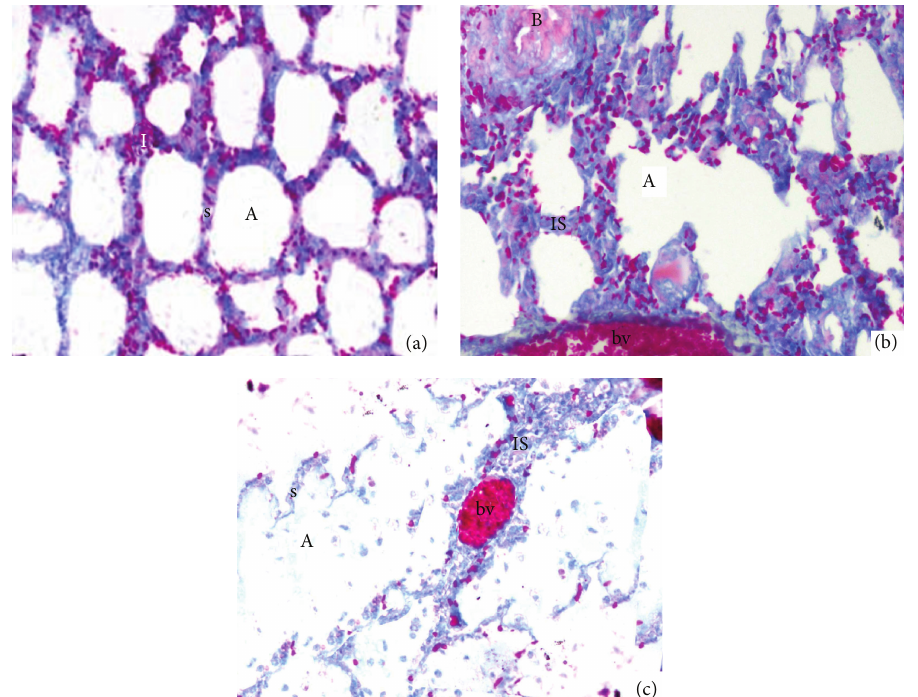
Figure 3: (a) A photomicrograph of transverse section in the control rat lung shows normal distribution of fibrous tissues and architecture of alveoli (A) with thin interalveolar septa (s) and normal interstitial tissues (I) (Mallory × 400). (b) A photomicrograph of transverse section in the second group rat lung shows mild distribution of fibrous tissues around alveoli (A) with thickening of the interalveolar septa (IS) and bronchiole (B) (Mallory × 400). (c) A photomicrograph of transverse section in the third group rat lung shows loss of normal architecture, increase of fibrous tissues around alveoli (A), subsequent compensatory dilatation of other alveoli, marked thinning of the interalveolar septum (s) with an increase of fibrous tissues in the areas of interstitial tissues (IS), and thickened and congested pulmonary blood vessels which contain hemorrhagic blood cells (bv) (Mallory × 400).